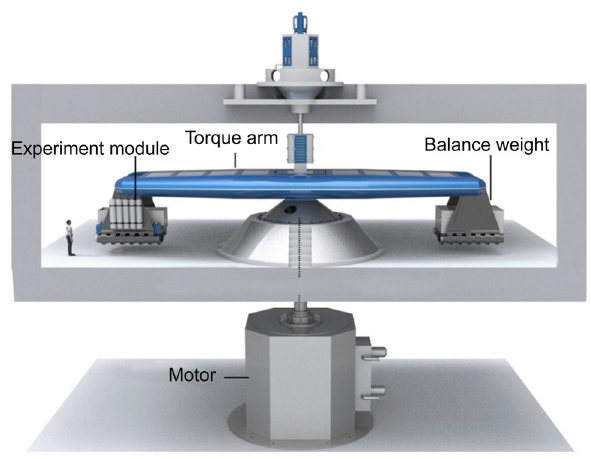
Fig. 1 Schematic of a geotechnical centrifuge